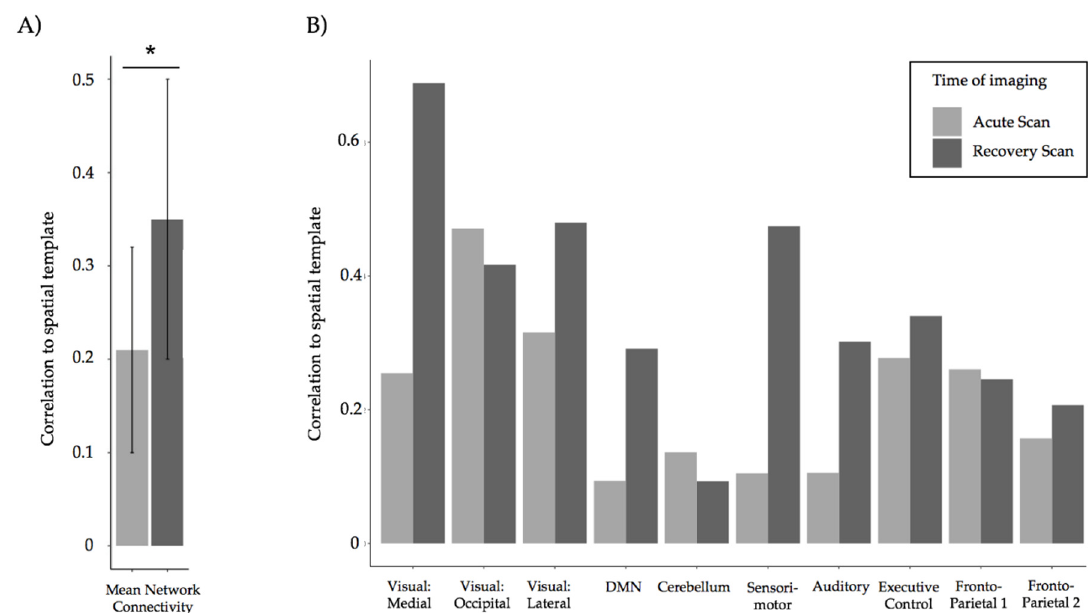
Figure 6. Resting state connectivity acutely and at recovery. ( A ) A significant increase in correlation to the spatial template averaged across 10 resting state networks were observed at recovery. The * denotes a significant di ff erence in correlation between the two time points. ( B ) Increases by at least two-fold in connectivity were observed in the visual medial, default mode, sensorimotor, and auditory networks at recovery.